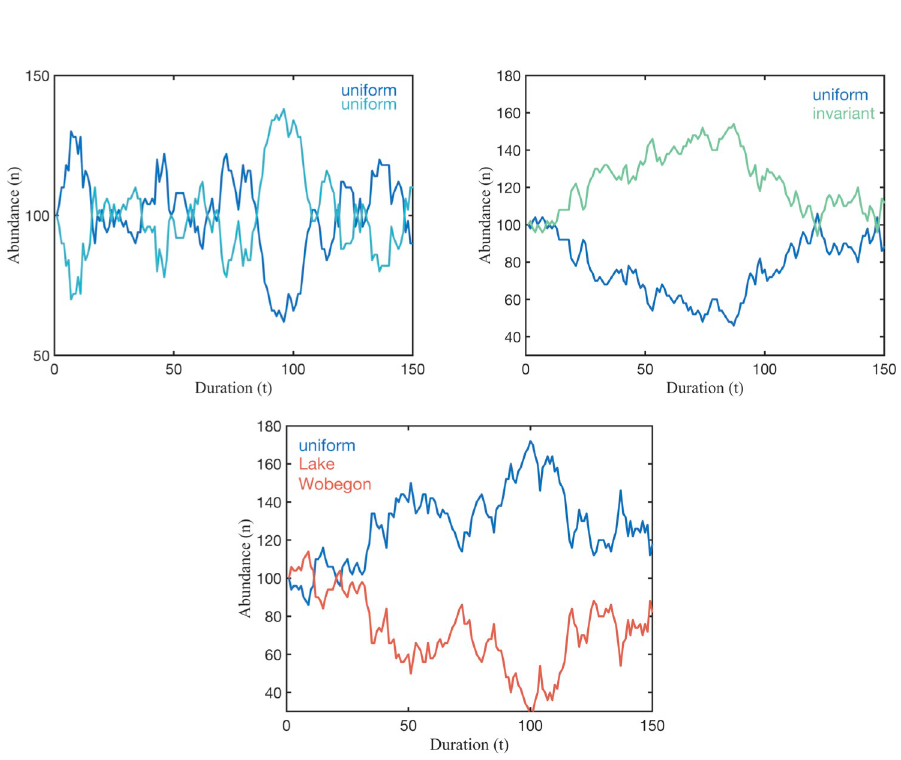
Fig 7. Equilibrium strategies resist invasion. Simulation results for larger population abundances and longer durations confirm the examples shown in the visualizations in Figs 4 through 6. A uniform distribution is an equilibrium strategy. It co-exists with all strategies that have the same mean competitive ability.